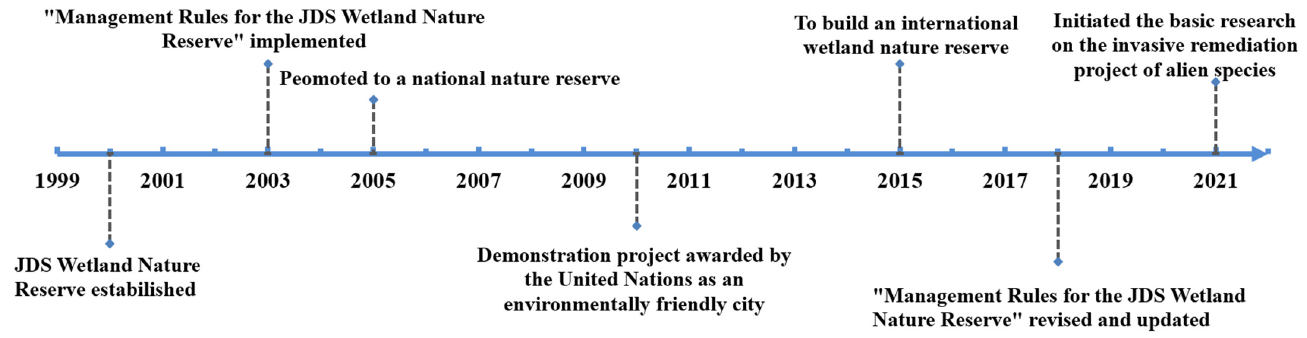
Figure 11. Major policies and plans issued regarding the JDS since 2000.